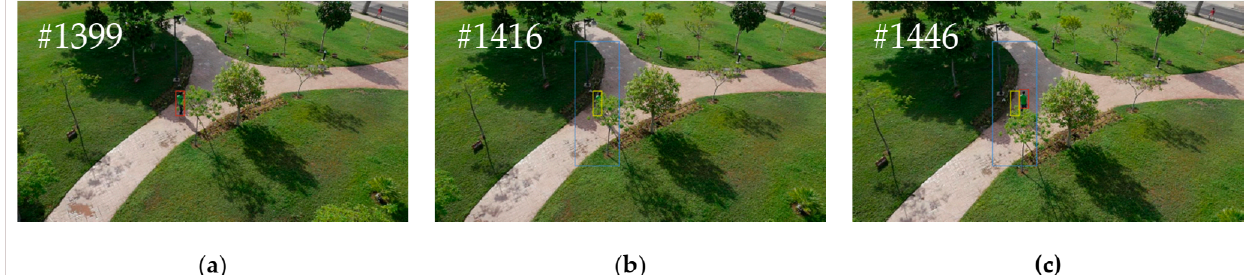
Figure 13. UAV123 datasets tracking test of person17. ( a ) The last tracked result before the object disappears; ( b ) object disappears, increasing searching window size twice time according to last tracked result; ( c ) object detected again inside the searching window.